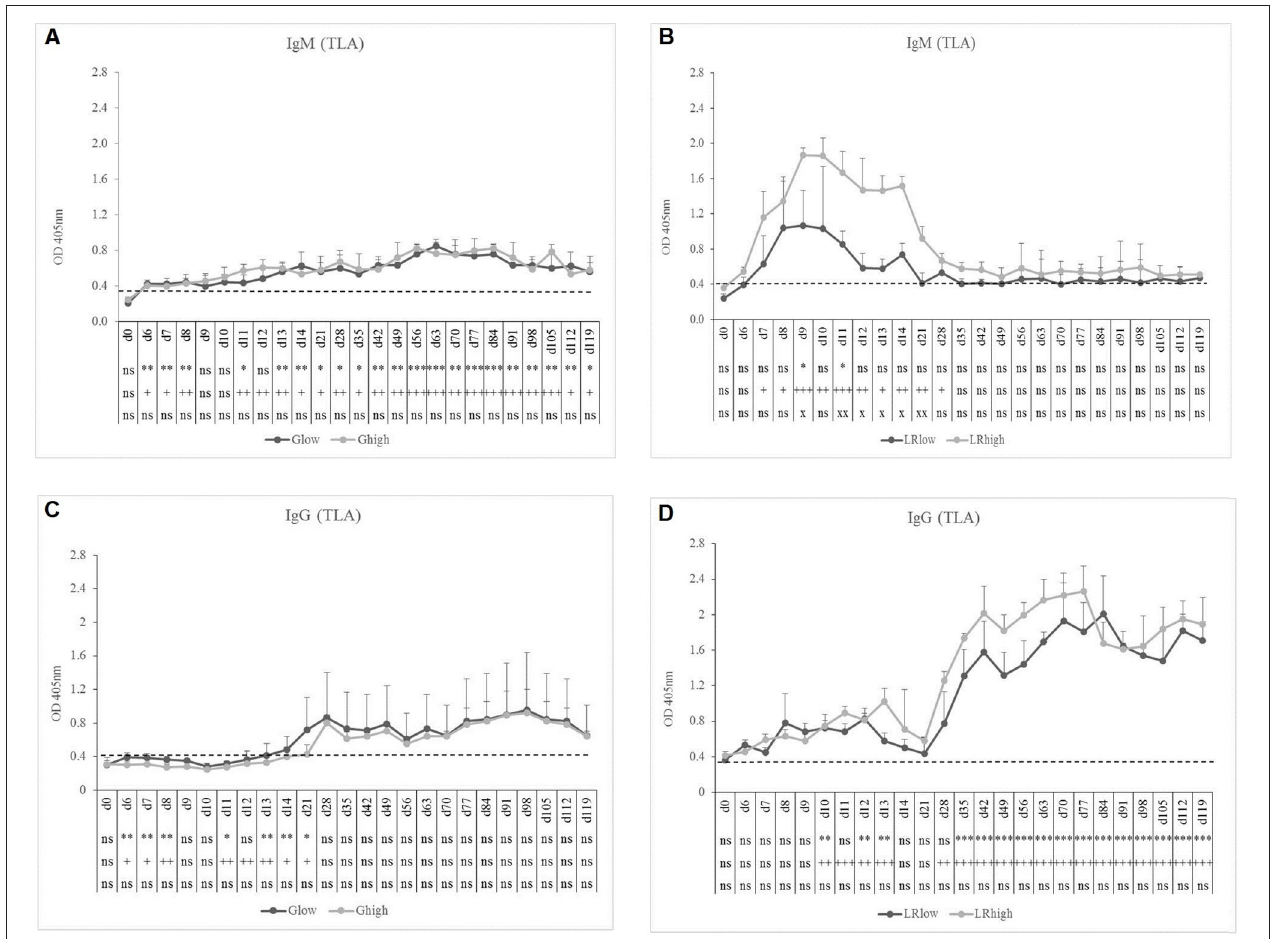
FIGURE 3 | TLA-specific IgM and IgG responses after inoculation with IPB-G or IPB-LR T. gondii strain. IgM (A,B) and IgG (C,D) responses in animals inoculated with a low or a high dose of the IPB-G (A,C) or the IPB-LR (B,D) strain. Groups: G low , G high , LR low , LR high . The horizontal dashed line indicates the cut-off value based on the mean of the negative animals. The results represent a mean of the infected group ± SD; * (low dose vs. controls) or + (high dose vs. controls) or x (low dose vs. high dose): P < 0.05, ** or ++ or xx: P < 0.01; *** or + + + : P < 0.001, ns, not significant.